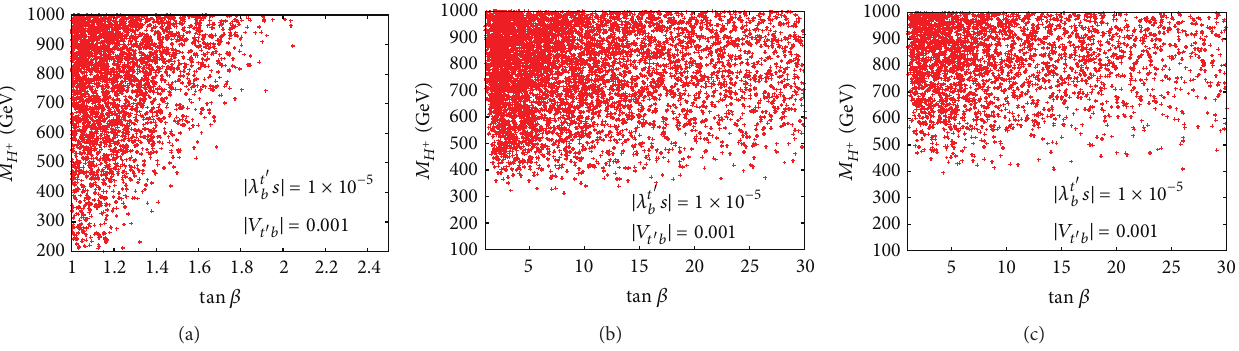
󸀠 | = 10 −5 ): the allowed parameter space in the 𝑚 𝑠𝑏